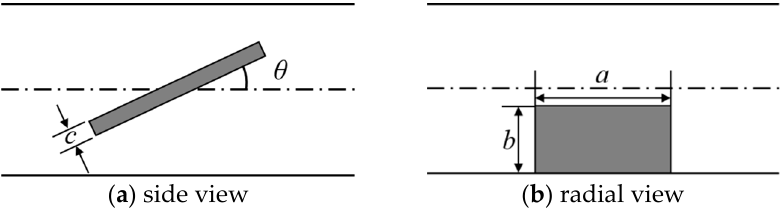
Figure 2. Schematic diagram of inlet guide vanes.